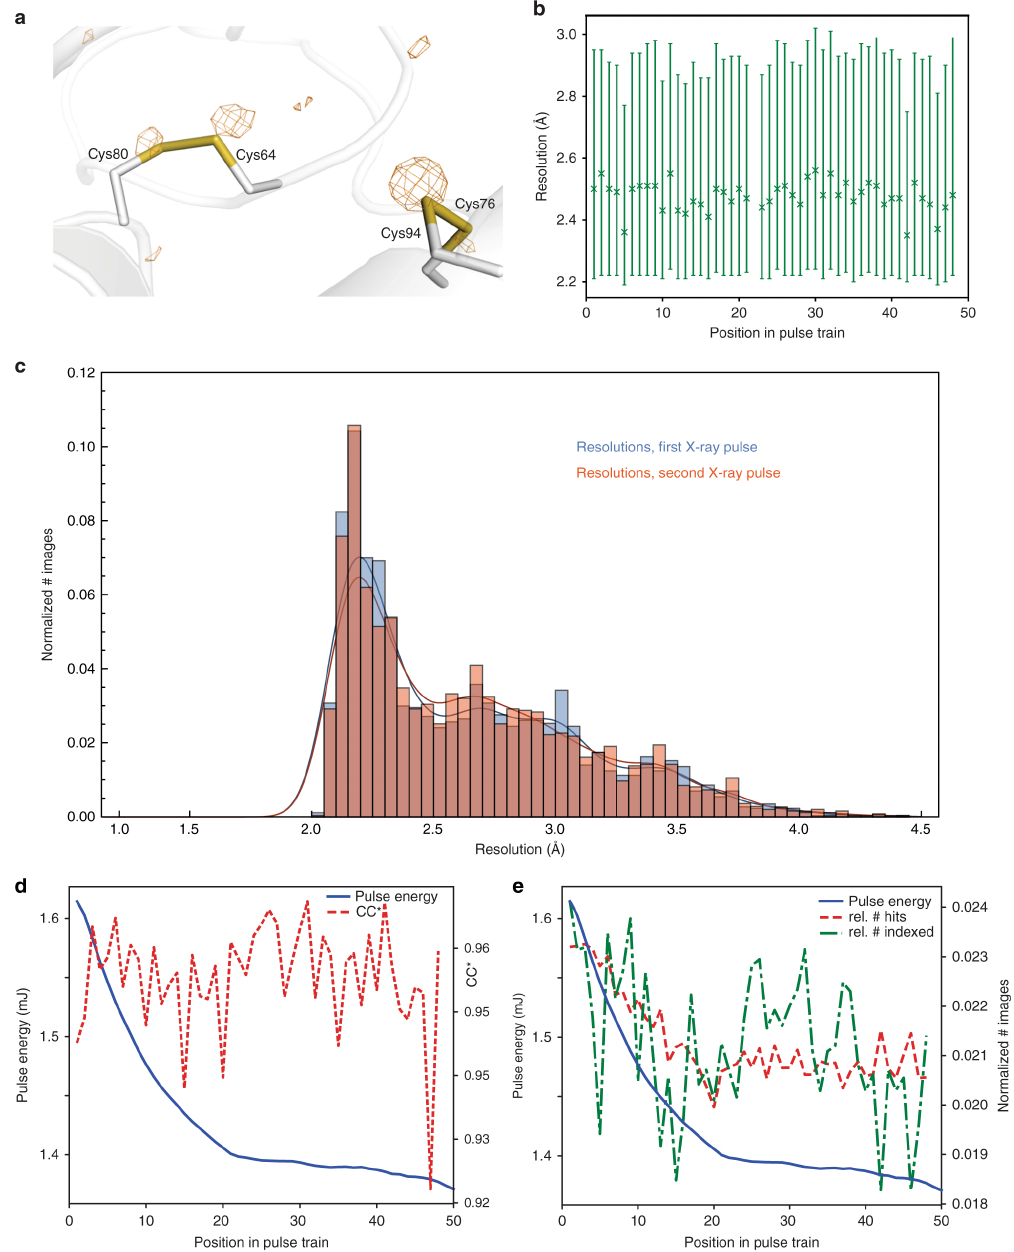
Figure 6. Image ( a ) and graph ( b ) show the length measurements of disulphide bonds per pulse. Both length and standard deviation are similar across all pulses. Histogram ( c ) highlights the similarities in data between the first and second pulse; these simularities can be extended to subsequent pulses, as shown in ( d , e ). Figure originally published in Nat. Commun.